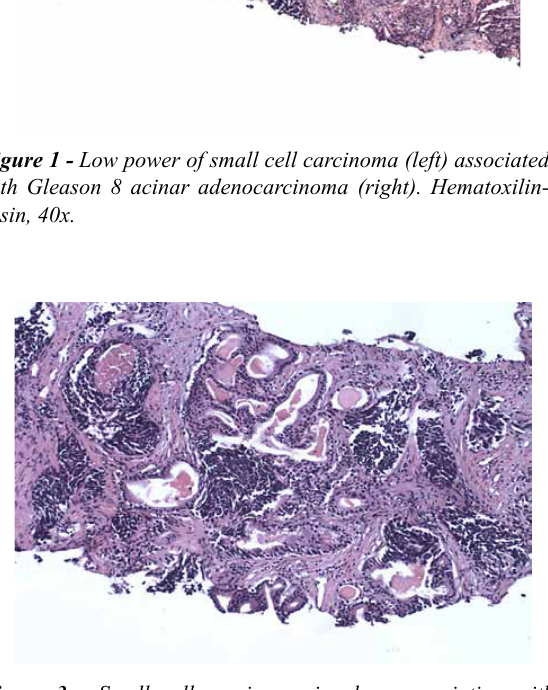
Figure 4 - Medium-power view of small cell carcinoma. The tumor tends to fragment on processing. Hematoxilin-eosin, 100x.